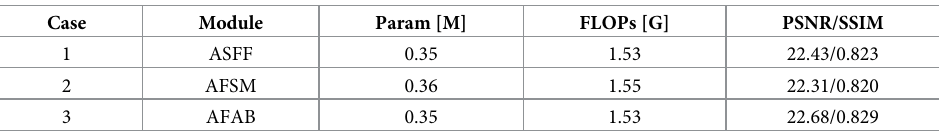
Table 8. Study on Adaptive Feature Aggregation Block